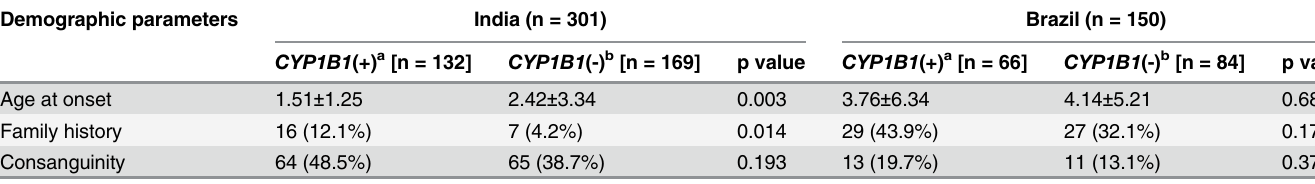
Table 1. Demographic profile of PCG patients in India and Brazil. Demographic